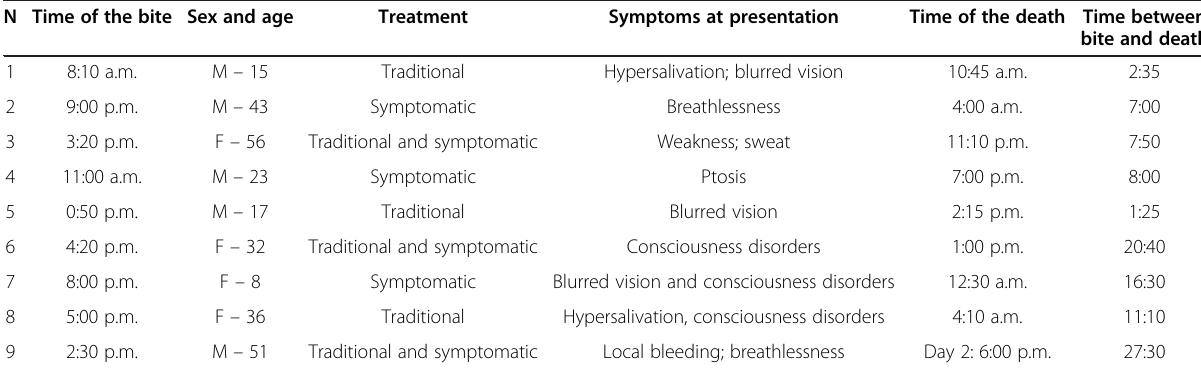
Table 2 Symptoms and time to death in patients of group 1